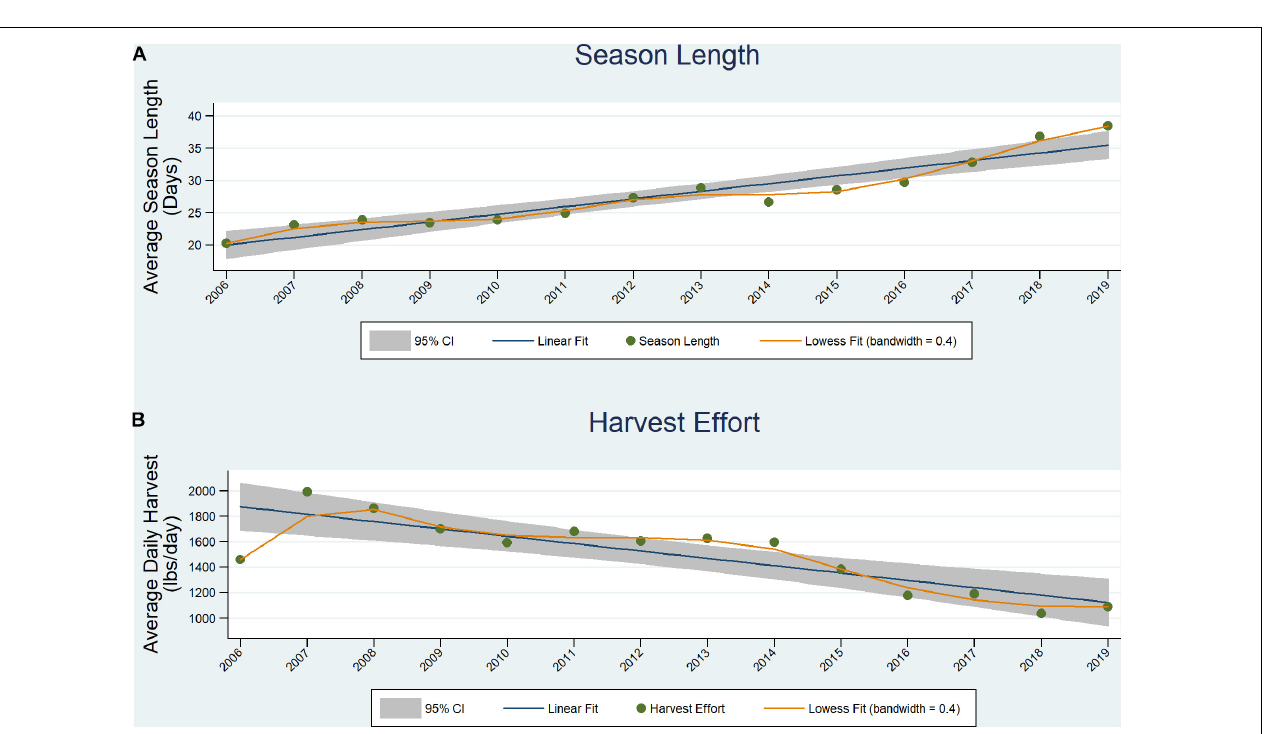
FIGURE 5 | Sablefish discard rates for the sablefish IFQ fleet in terms of the percent of the number of fish that are discarded, based on observer and electronic monitoring data.